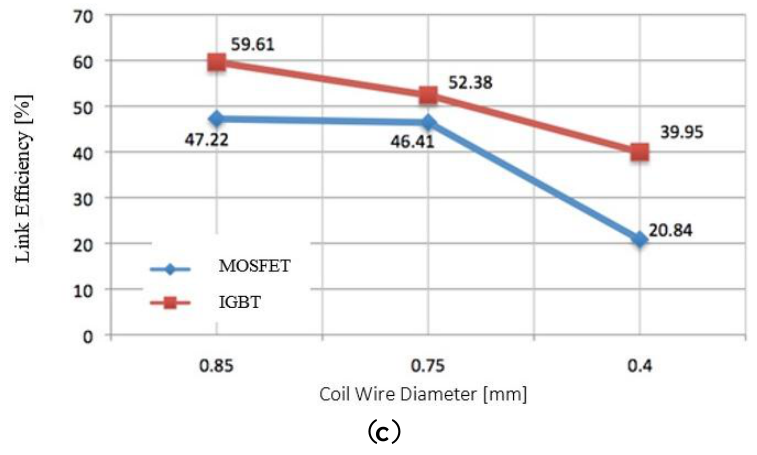
Figure 6. ( a ) Link efficiency versus resonant frequency as a function of inter-coil separation; ( b ) gain-frequency characteristics versus resonant frequency and ( c ) measured